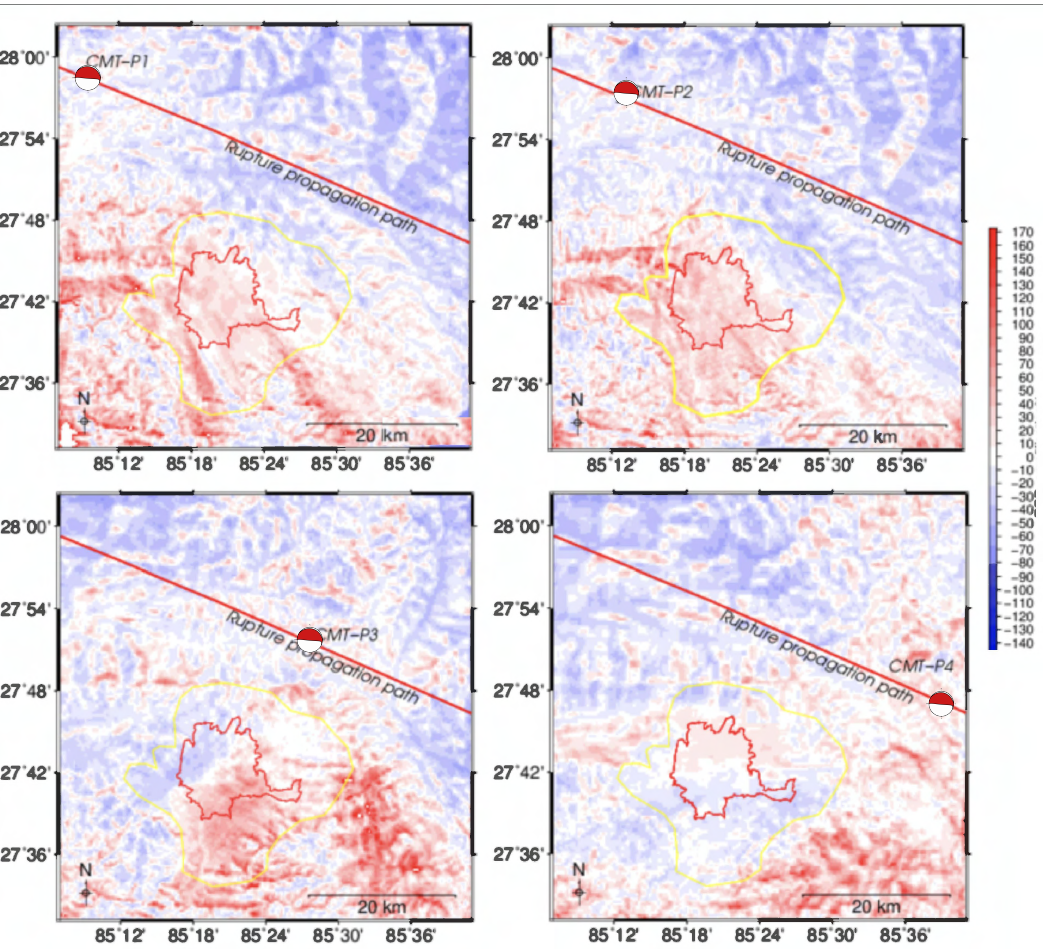
Figure 5. PGD amplification for scenarios with centroid moment tensor (CMT) at four different locations (P1 to P4) along the fault-rupture line. Subfigures show the expected amplification outcomes for maximum seismic energy release at points P1, P2, P3, and P4, as indicated in the